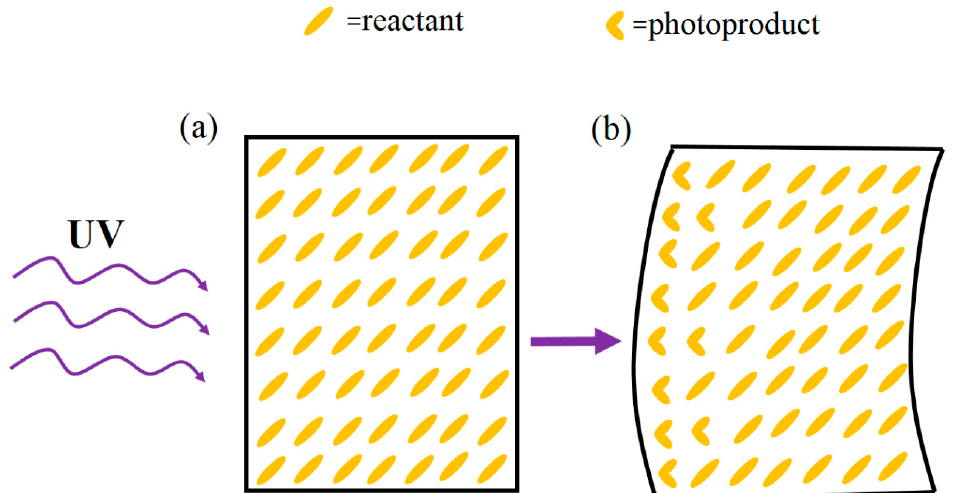
Figure 8. Schematic illustration of the mechanism of photoinduced motion upon irradiation of the UV light. ( a ) The ordered arrangement of photoactive molecules before UV light irradiation. ( b ) The incident UV light leads to trans to cis photoisomeriaztion on the crystal surface and the stress between two regions drives the visible deformation of the crystal.